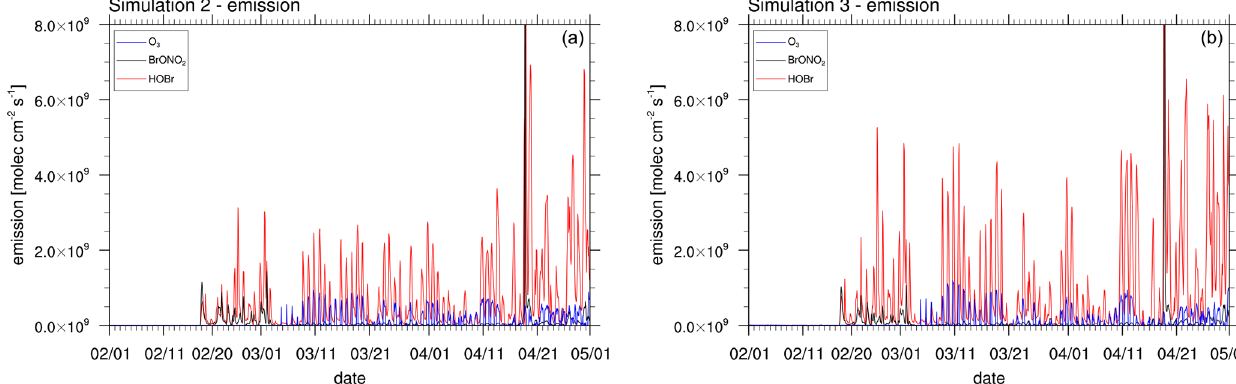
Figure 16. Emission rate of Br 2 due to HOBr and BrONO 2 and due to bromide oxidation by ozone from the snow surface at coordinates 78 ◦ N, 178 ◦ W for (a) simulation 2 with β = 1 and (b) simulation 3 with β = 1 . 5. The data are shown at 06:00GMT +